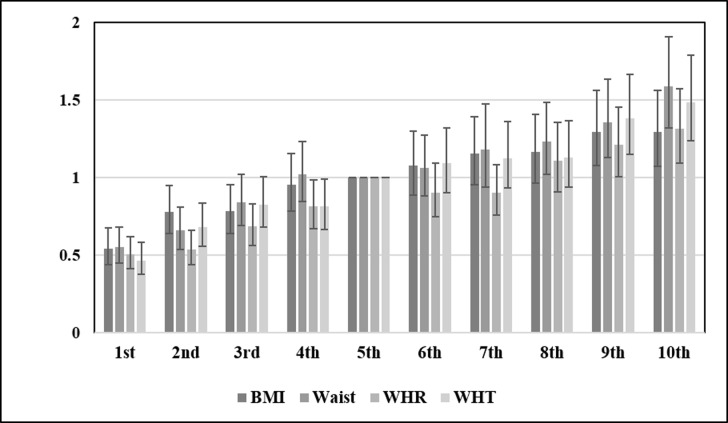
Comparing adjusted ORs for deciles of anthropometric measurements.The fifth decile serves as the reference group. Each decile includes approximately 1,100 participants. BMI: Body Mass Index, WHR: Waist to Hip Ratio, WHT: Waist to Height Ratio.